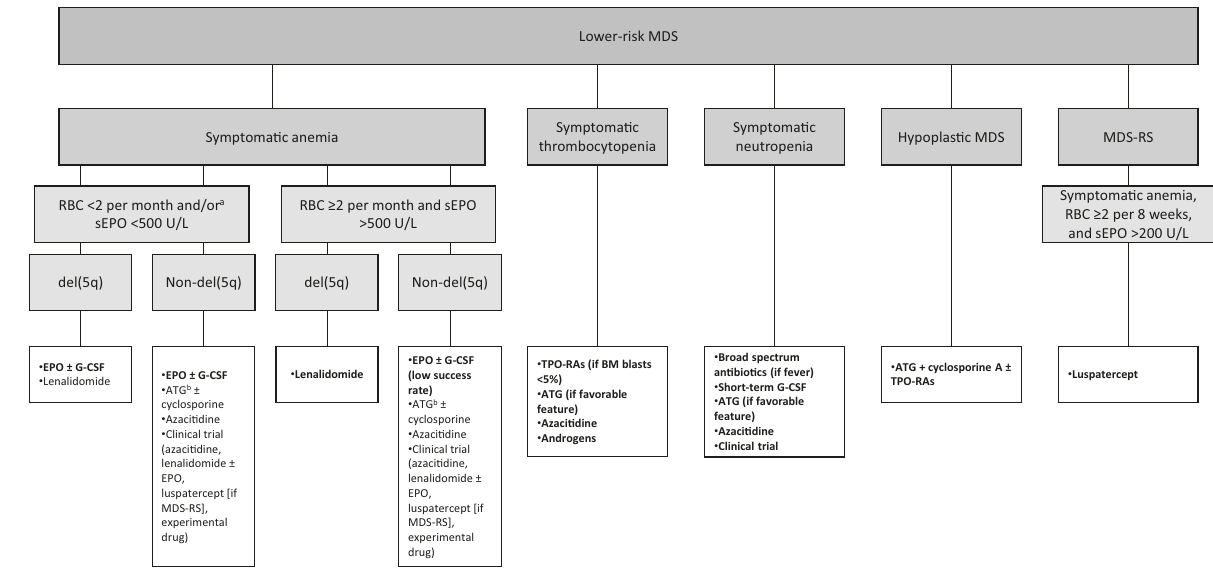
Fig. 2 Current treatment options for lower-risk MDS. Bold text indicates fi rst-line therapy. a ESMO 2014 [45]: RBC <2 per month or sEPO <500 U/L. b ESMO 2014 [45]: if age <60 – 65 years and favorable features (including hypoplastic BM, blasts <5%, normal karyotype, HLA-DR15- positivity, younger age [<60 years], lower risk according to IPSS [10, 95]) for response to ATG; ESMO 2021 [16]: if age <65 – 70 years and favorable features for response to ATG. Abbreviations: ATG anti-thymocyte globulin, BM bone marrow, EPO erythropoietin, ESMO European Society for Medical Oncology, G-CSF granulocyte colony-stimulating factor, IPSS International Prognostic Scoring System, MDS myelodysplastic syndromes, MDS-RS myelodysplastic syndrome with ring sideroblasts, sEPO serum erythropoietin, TPO-RA thrombopoietin-receptor